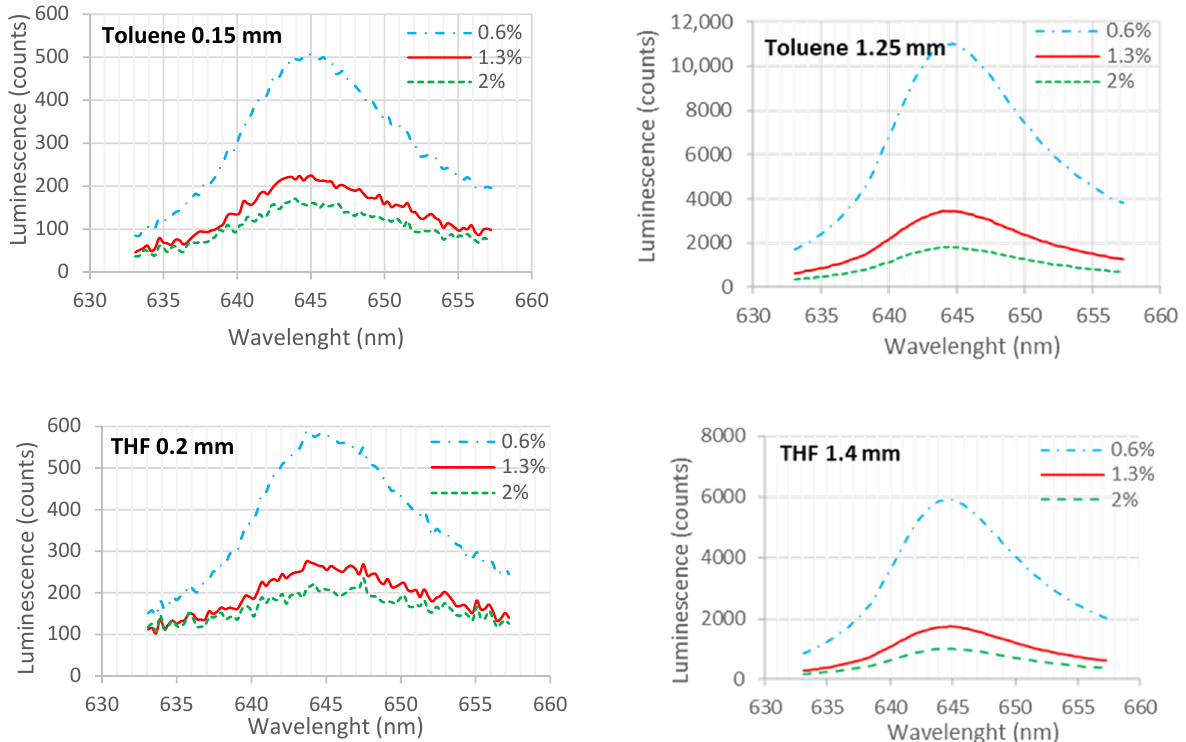
Figure 9. Luminescence spectrum of THF and toluene-based membranes with a concentration of 363 ppm, for thin and thick membranes, respectively, 0.15–0.20 mm and 1.24–1.4 mm. Each line in the graphs was obtained with different oxygen concentration (gaseous media) with oxygen concentration of 0.6%, 1.3% and 2%. Table 2. Characterization of